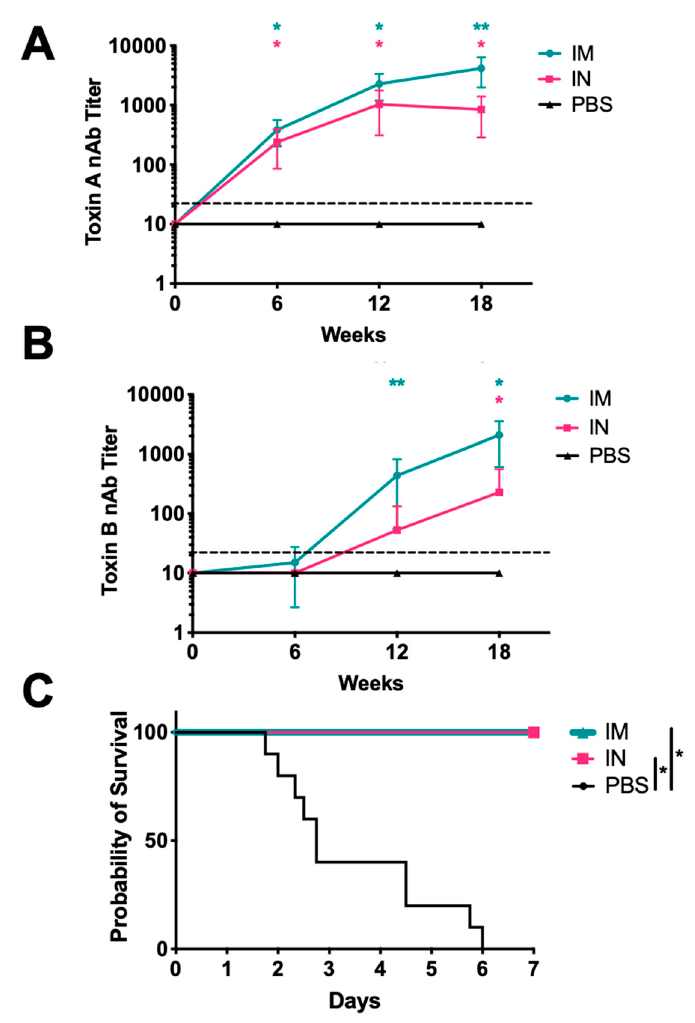
Figure 3. Serum-neutralizing antibody responses in immunized Syrian hamsters and protection from lethal spore challenge. Female Syrian hamsters (n = 10) were vaccinated i.n. or i.m. with 1 × 10 11 virus particles of SC-Ad6-TcdA / B, or i.n. with PBS. Serum collected at 6, 12, and 18 weeks after immunization were assayed to determine mean neutralizing titers for ( A ) toxin A and ( B ) toxin B. In both panels, points show the mean titer, bars show standard deviation, and the dotted line indicates the limit of detection (*Adjusted p < 0.05 compared to control, **Adjusted p < 0.05 compared to control and i.n. route). ( C ) Survival curve for SC-Ad-TcdA / B vaccinated animals challenged with UK1 spores shows significant protection compared to PBS control animals (* p <